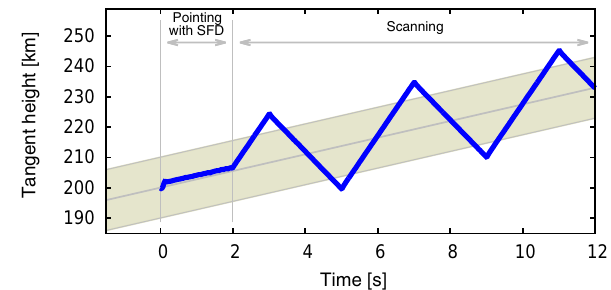
Figure 3. Sun over limb port measurement sequence. (b) In eleva- tion, the solar disk (yellow area) is scanned by movements of the ESM mirror (blue line), which overall follows the rising sun. In to- tal, 36 scans are usable for the pointing investigations. (a) By fitting the maximum intensity in each scan, the elevation angle of the cen- tre of sun is measured for the time of maximum intensity.